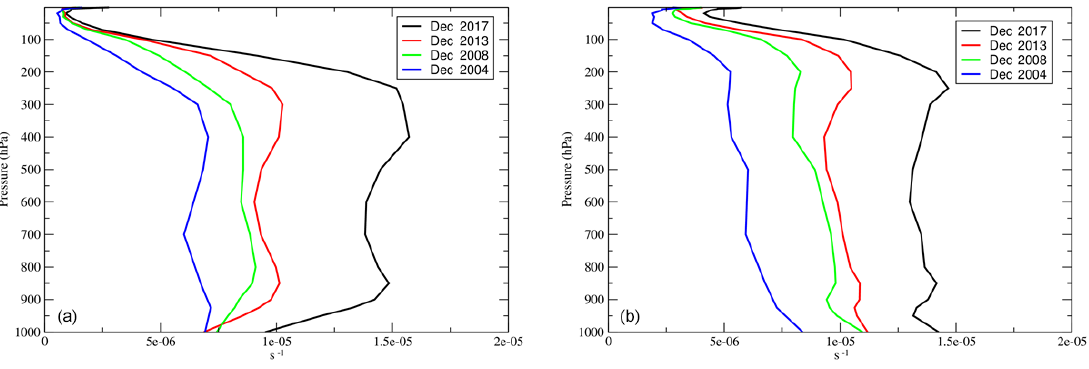
(cid:16) (cid:17) (cid:16) (cid:16) (cid:17) (cid:17) − + M δ x n M x n − 1 + δ x n x n − 1 in the last minimi-